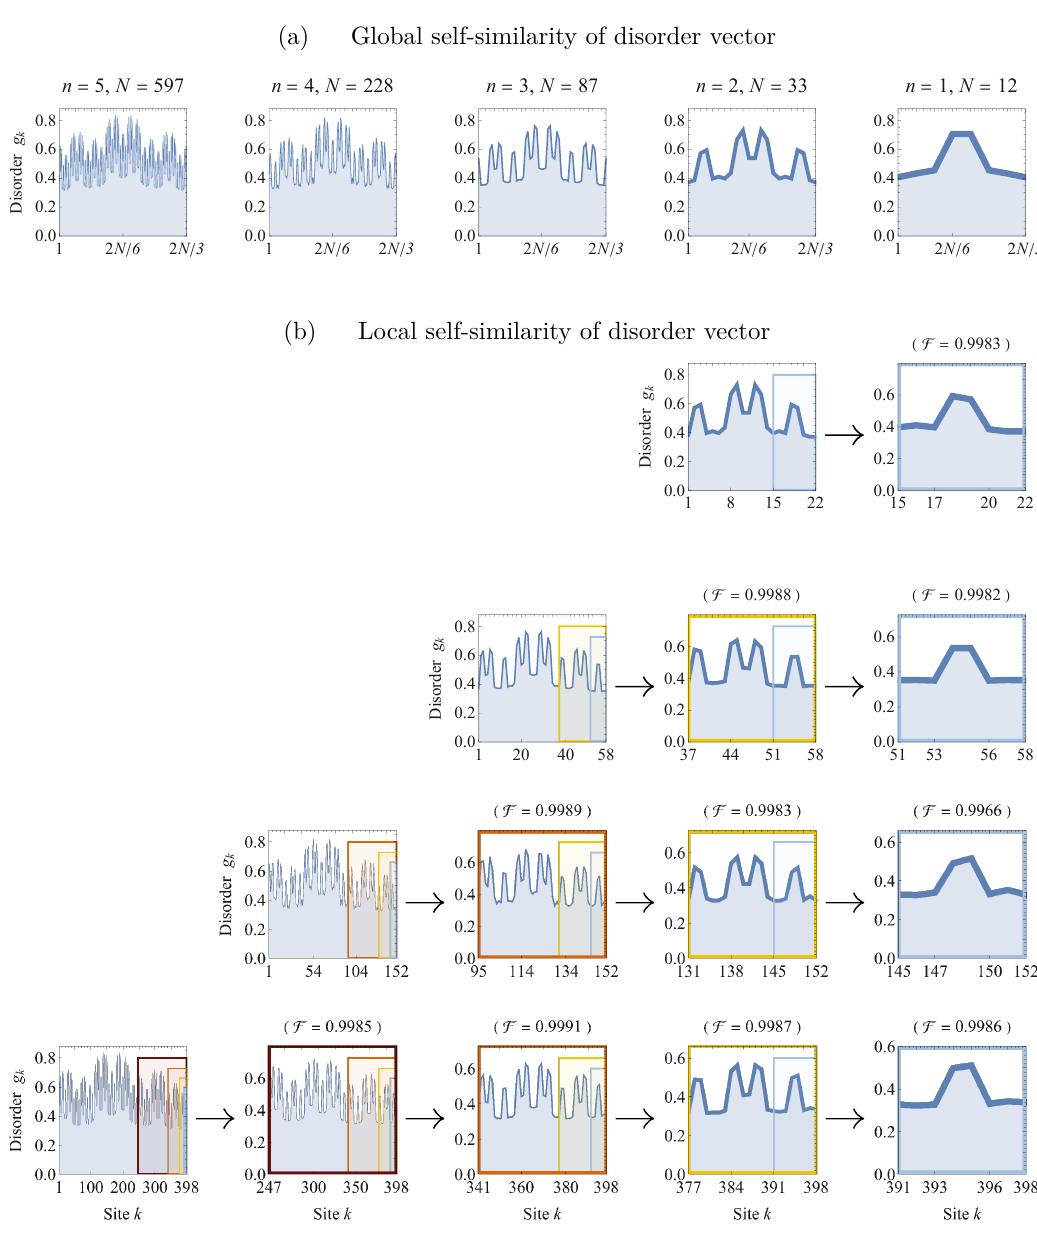
Figure 8 . (a) The disorder vector g after n = 2 , 3 , 4 , and 5 inflation vertex inflation steps (right to left) of the { 3 , 7 } tiling at the critical Ising point. Only a third of the total system is shown, as the Z 3 symmetry leads to a repeating pattern on the remaining sites. We a find a gradual refinement of the disorder vector at a larger number of inflation steps. (b) Subsystems (coloured frames) of the disorder vector for N = 597 , 228 , 87 , and 33 , slightly site-shifted for easier visualization. We find a self-similarity between total system and subsystems resembling the scaling between inflation steps, up to a global rescaling factor. The fidelity F between subsystems and rescaled total system (top row) is quoted above each plot (with the site shift taken into